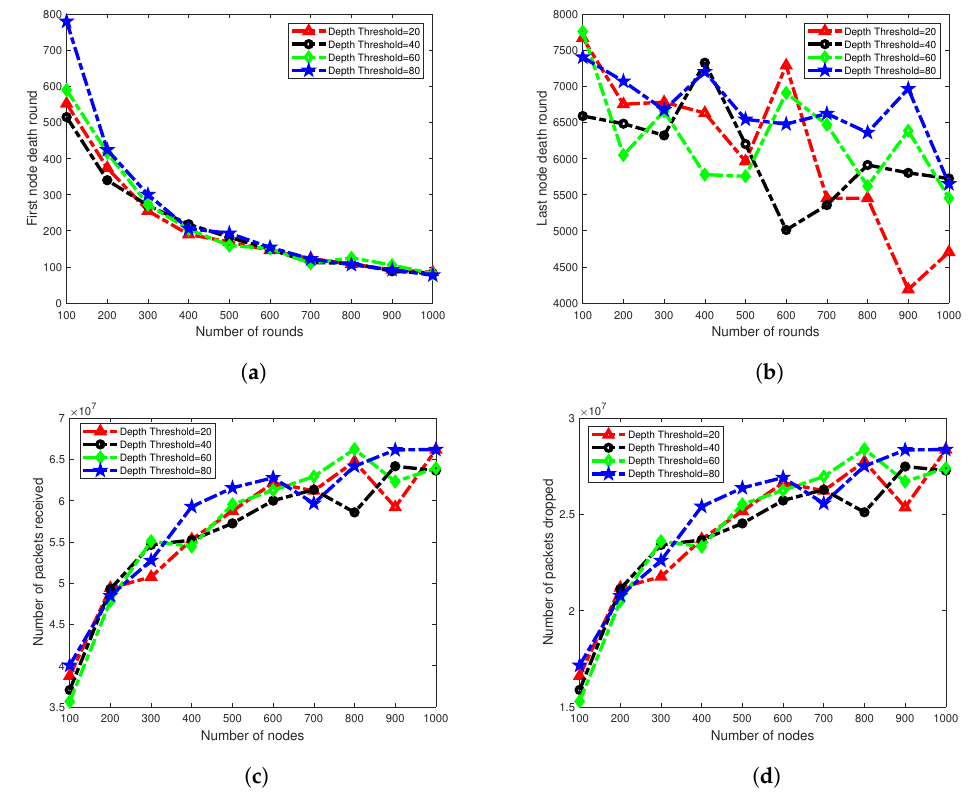
Figure 12. Scalability Analysis. ( a ) First node died analysis; ( b ) All nodes died analysis; ( c ) Packets received analysis; ( d ) Packets dropped